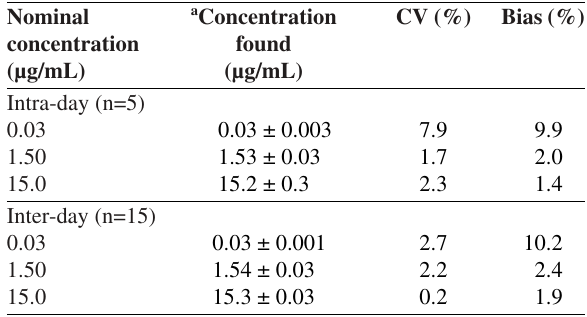
Table 3. Intra- and inter-day precision and accuracy for the deter- mination of TPM in human plasma by HPLC-FLD